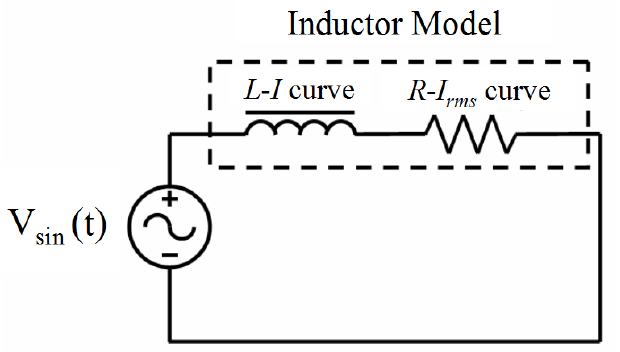
Figure 12. Diagram representing the used inductor